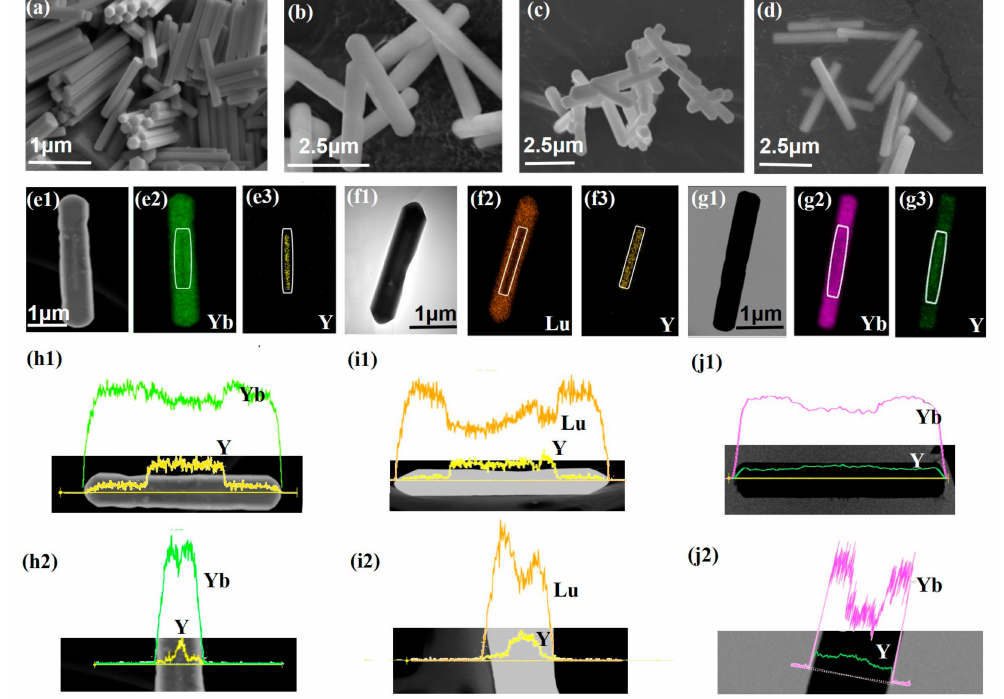
Figure 1. ( a – d ) SEM images of the microcrystals, NaYF 4 :Yb/Er (20/2 mol %, Y), NaYF 4